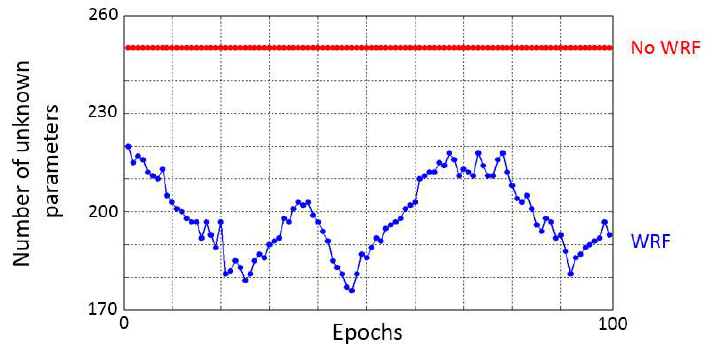
Figure 9. Comparison of the number of unknown parameters at different epochs .